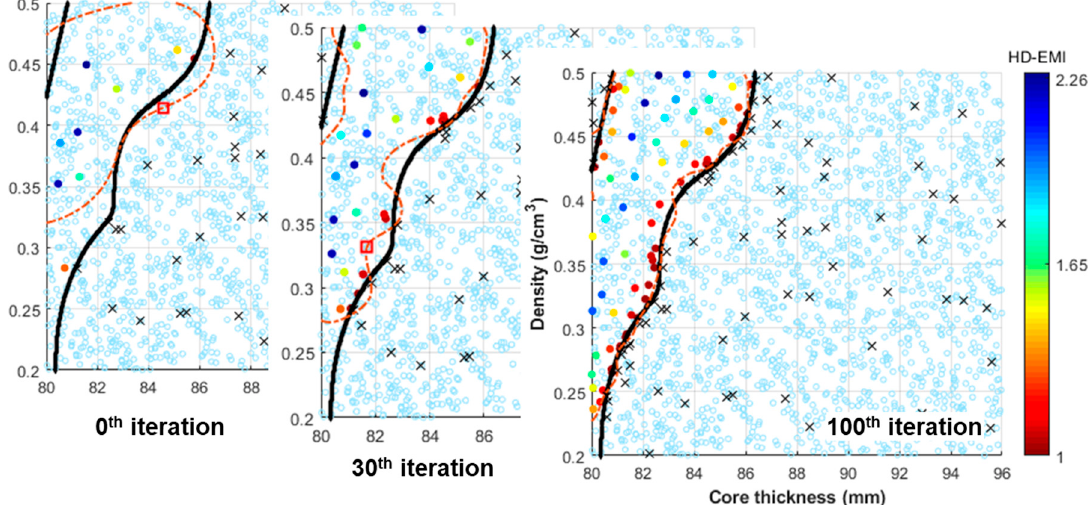
Figure 8. SVM active learning iterations at property level.